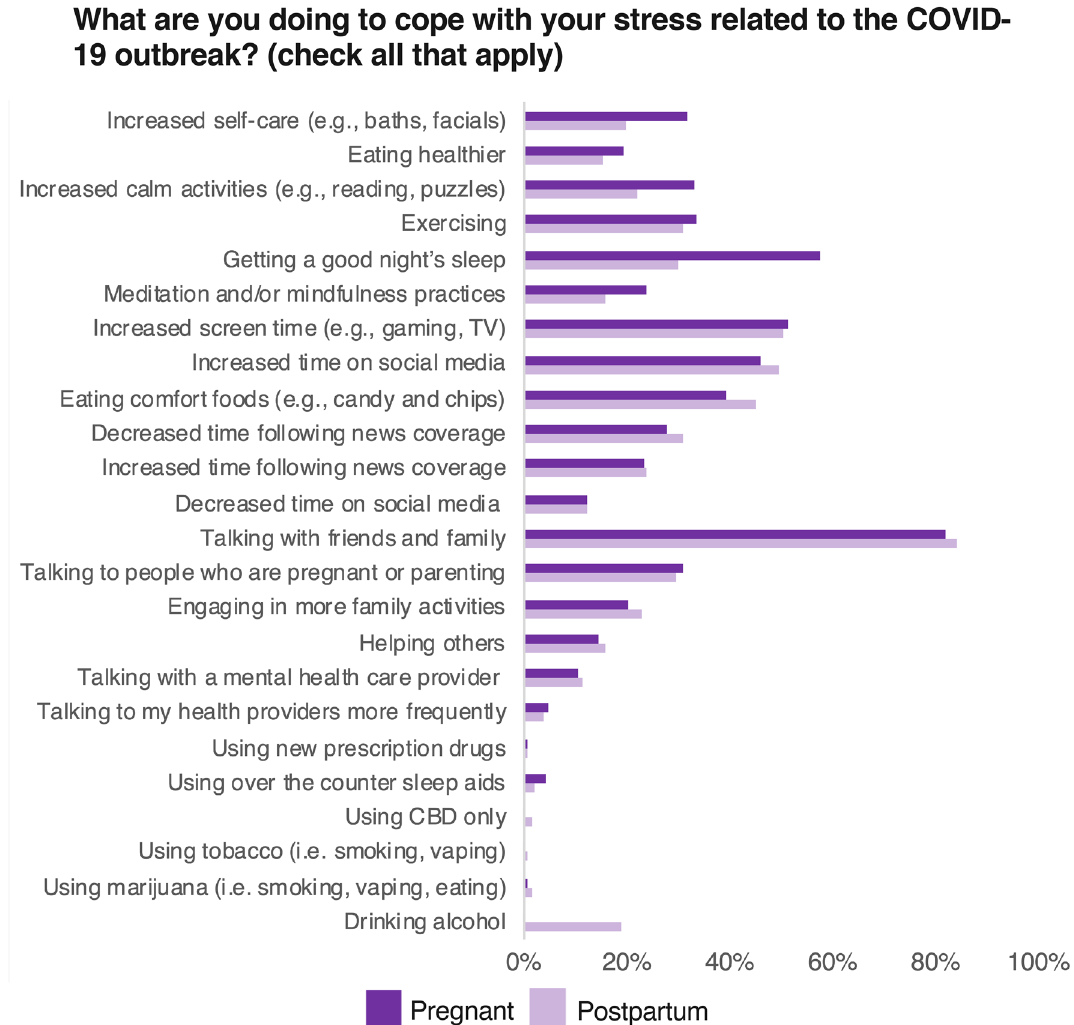
Figure 2. Percentage of pregnant and postpartum women endorsing each coping behavior survey